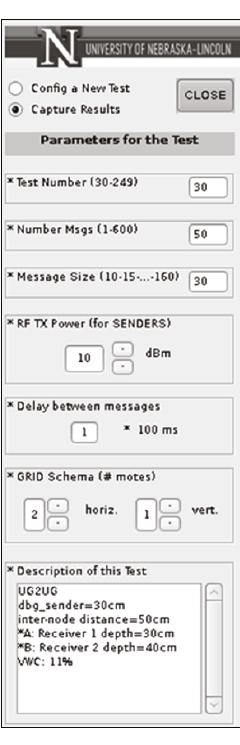
Figure 10: A screenshot of the WUSN testbed software running in a